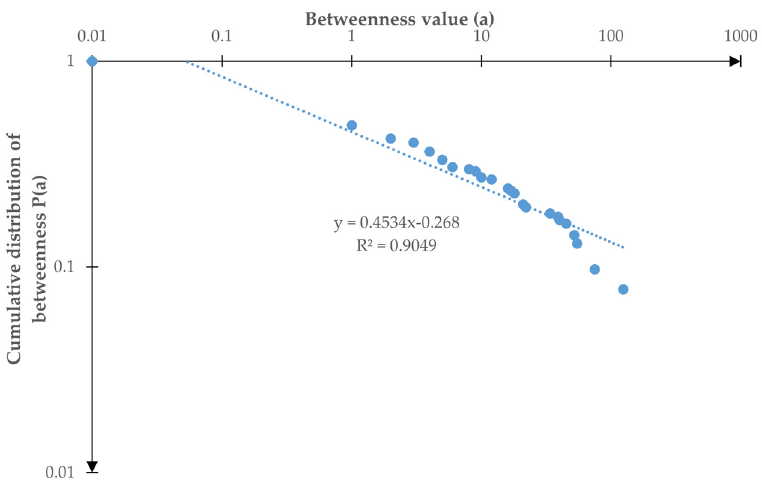
Figure 8. The cumulative distribution of betweenness.